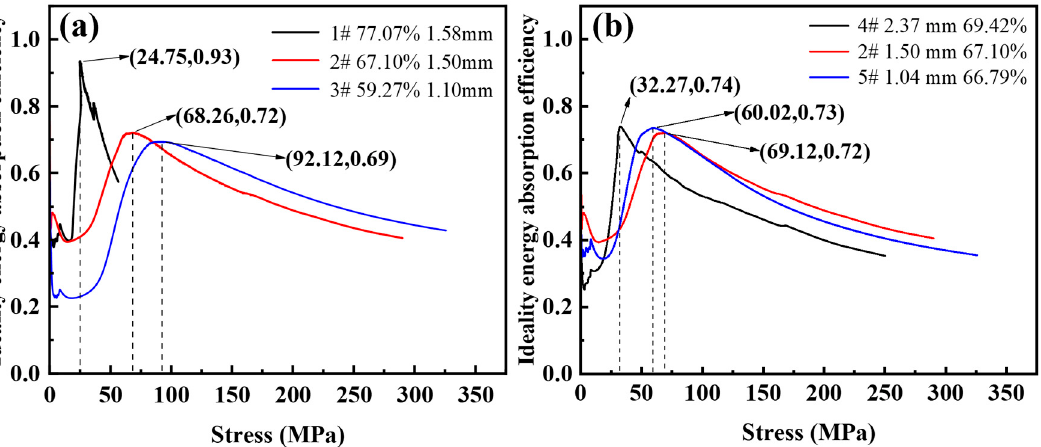
Figure 10. Ideal energy absorption efficiency-stress curve of ( a ) different porosity and ( b ) different pore size.